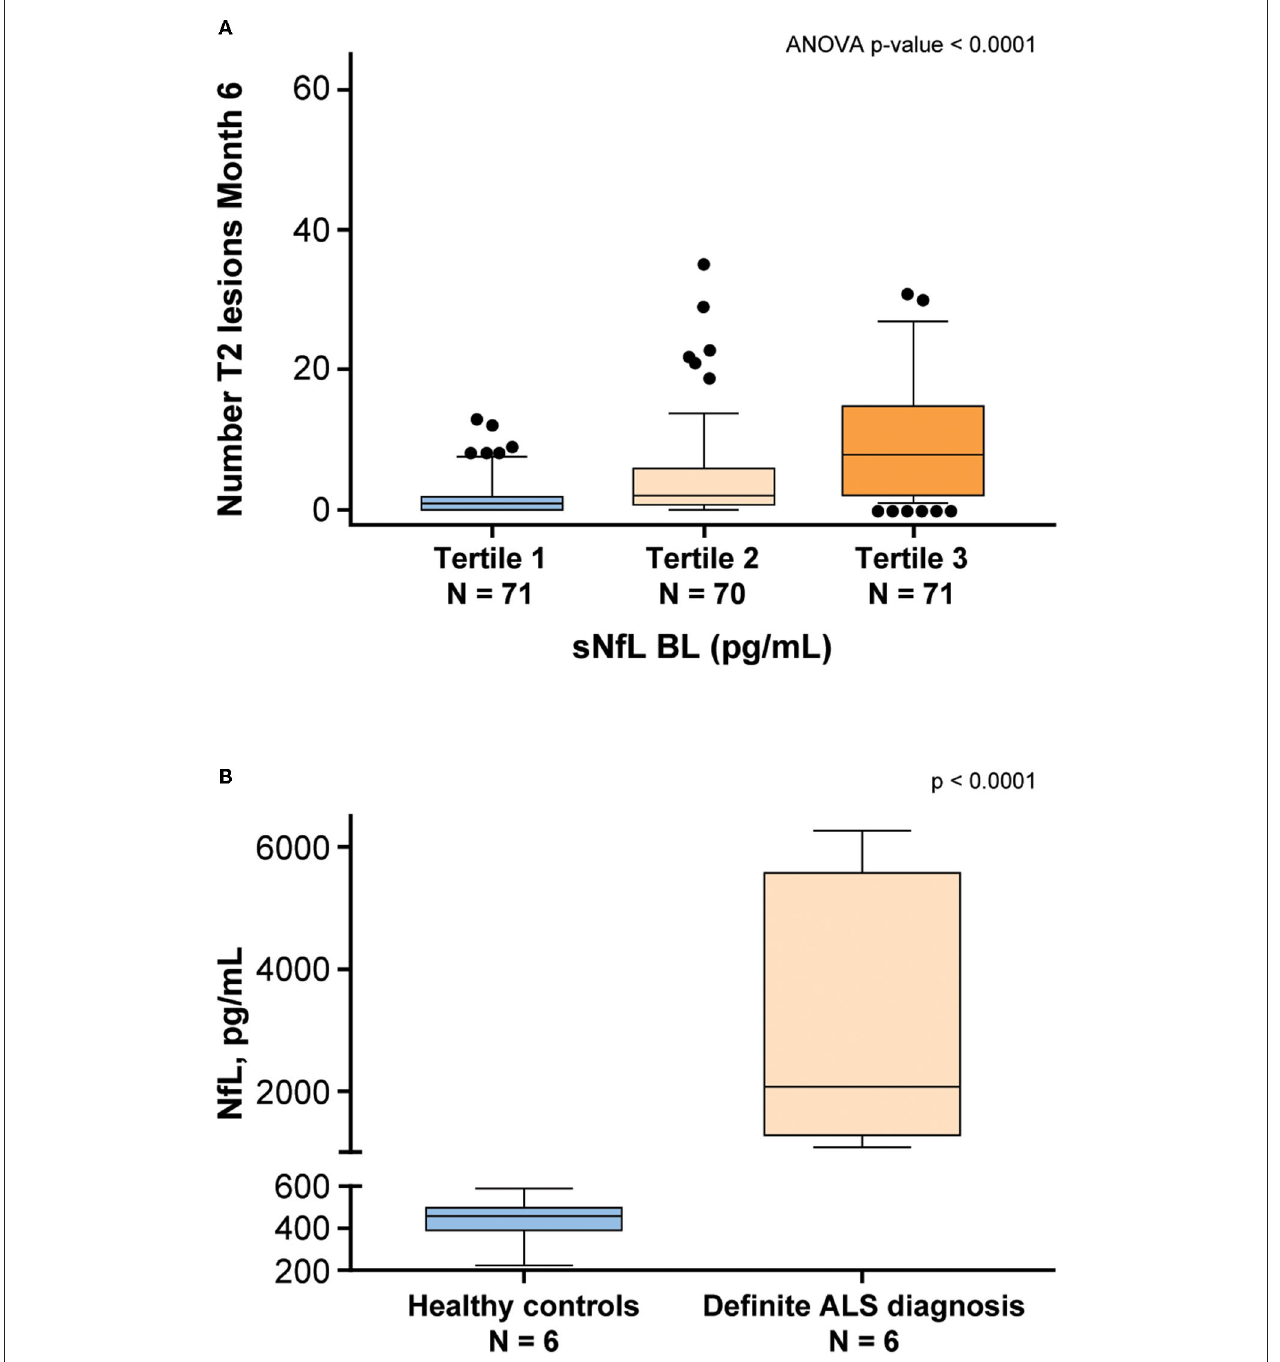
FIGURE 8 | NfL levels are associated with neurodegenerative disease. (A) Patients with multiple sclerosis (MS) from the ADVANCE study (11) were separated into tertiles based on baseline (BL) sNfL. The vertical axis shows the number of T2 lesions that developed 6 months later. The lower and upper limits of each tertile were 5.6–11.3 pg/mL for tertile 1, 11.4–22.1 pg/mL for Tertile 2, and 22.4–100.4 pg/mL for tertile 3. (B) NfL levels were assessed in the CSF derived from healthy controls and patients with a definite ALS diagnosis. ALS, amyotrophic lateral sclerosis; ANOVA, analysis of variance; BL, baseline; CSF, cerebrospinal fluid; NfL, neurofilament light chain; sNfL, serum neurofilament